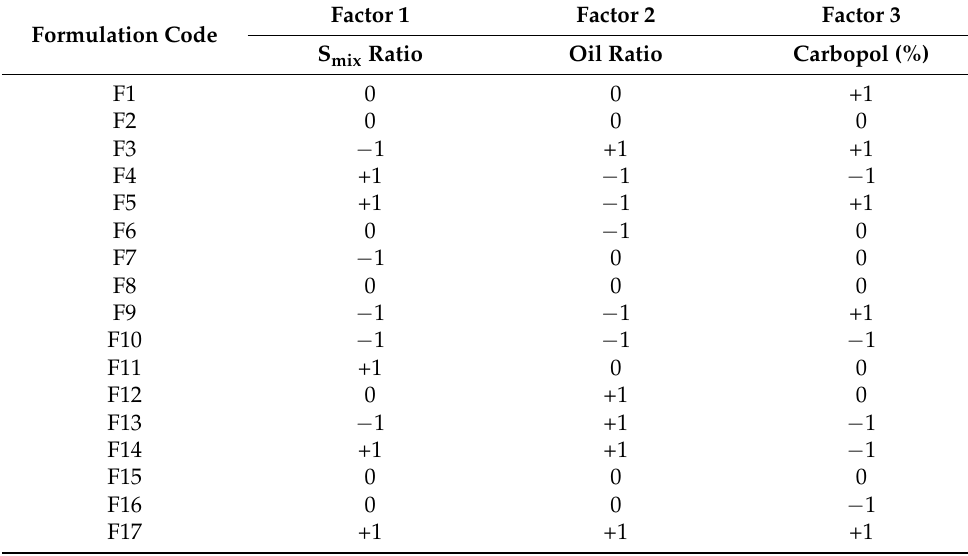
Table 2. 2 3 Levels of factorial randomized central composite design experimental trial batches for